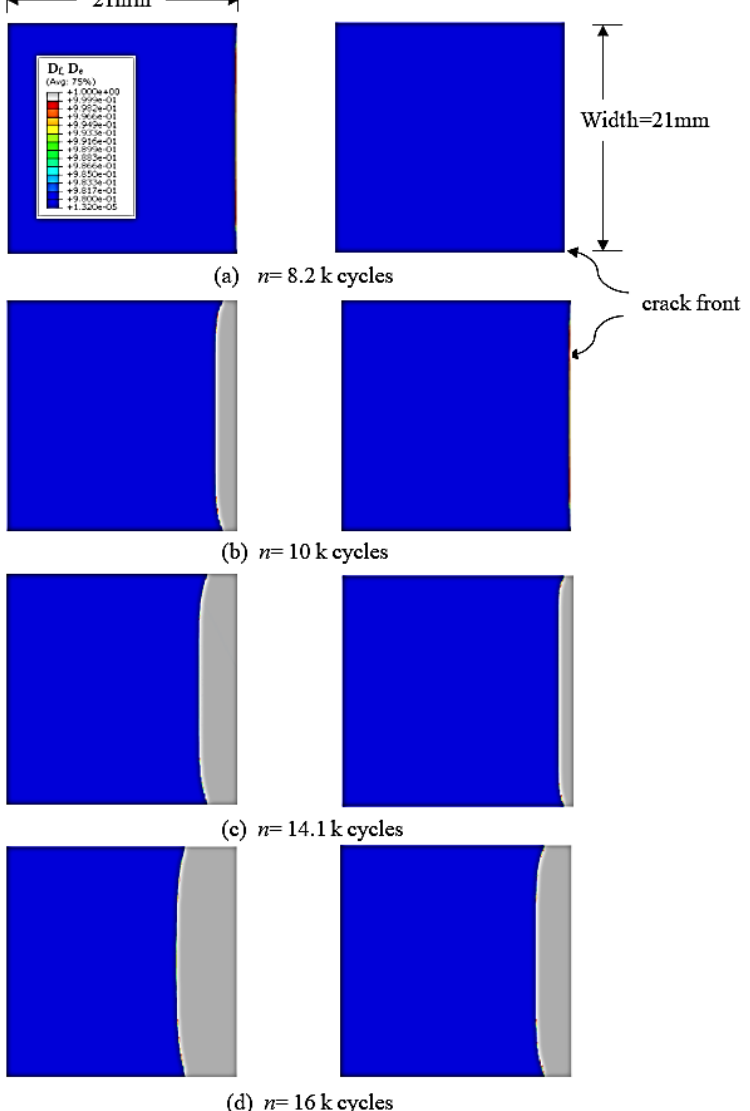
Figure 11. Evolution of damage variables Df (left column) and De (right column) at various stages of the fatigue cracking process: the ( a ) onset of fatigue crack nucleation, ( b ) formation of the first crack increment, ( c ) end of the interface crack growth stage with constant growth rate, and ( d ) end of the fast crack growth stage. The normalized penalty stiffness and the normalized number of cycles for the ex- perimental and FE-calculated results are compared in Figure 12. Comparing the experi- mental results with the FE-predicted results for the number of cycles to failure ( N f ) shows a very successful validation of the interlaminar fatigue damage model.